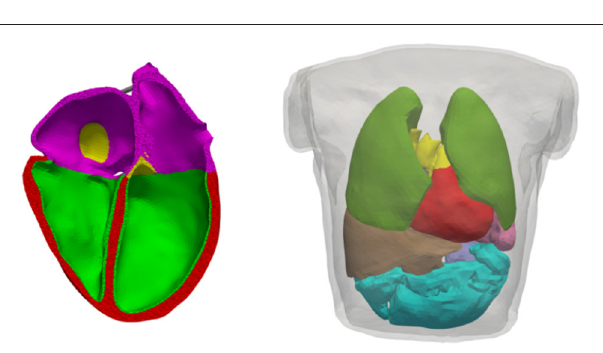
FIGURE 2 | Volumetric geometries used for electrophysiological simulations. Left: Cut of the heart mesh; myocardium where the endo variant of the OVVR model is used (green), myocardium where the epi variant of the OVVR model is used (red), atrial wall (purple), blood vessels (yellow). Right: Torso mesh as used for forward calculation of the ECG; lungs (dark-green), liver (brown), spleen (lavender), intestine (turquoise), others as left side. Both models are based on the same volunteer as published by Keller et al.